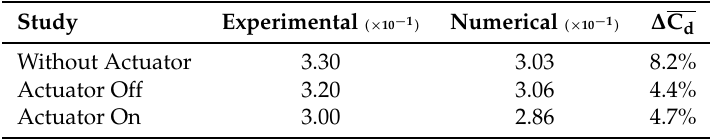
Table 3. Comparison of the experimental and numerical C d .